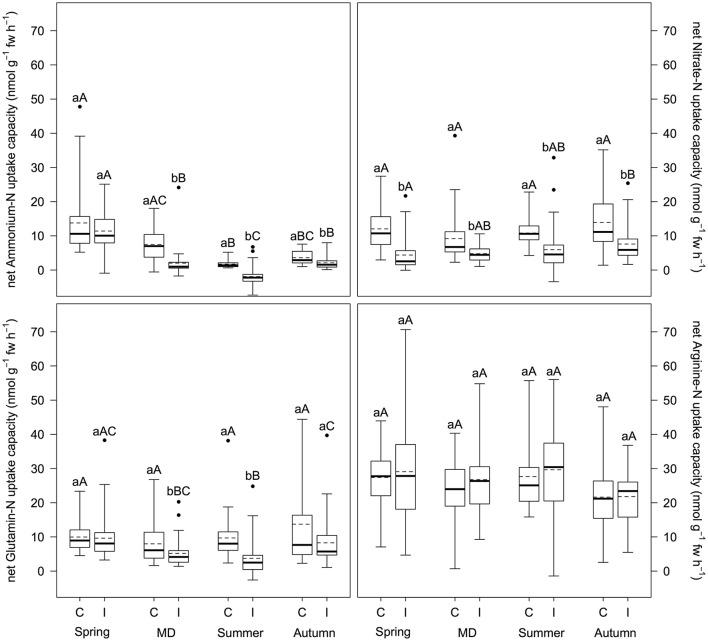
Inorganic and organic net N uptake capacity (nmol g−1 fw h−1) at infested and non-infested pine forests over the vegetation period. I, infested; C, control; MD, main defoliation. Box plots show means (dotted lines) and medians (straight lines) (n = 12 for each plot). Whisker extension equals 3x interquantile range distance. Different small letters indicate significant differences between infested and control plots within one sampling time (p ≤ 0.050). Different capital letters indicate significant differences between the sampling times within one treatment (p ≤ 0.050).